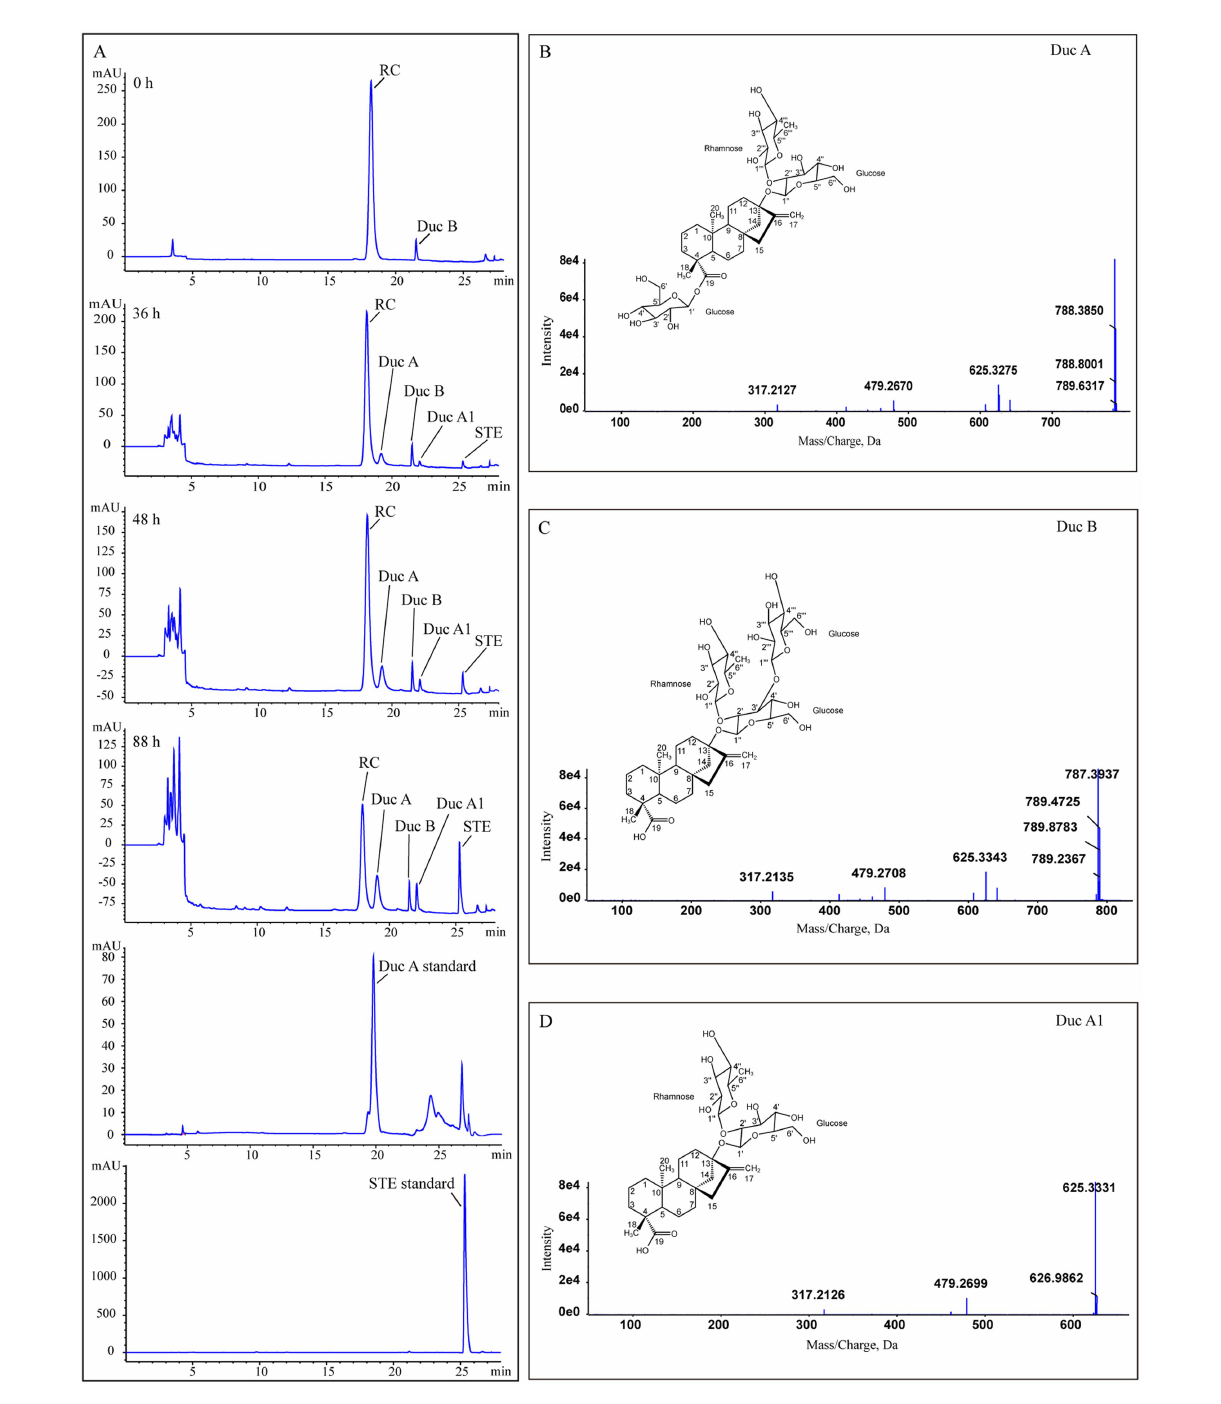
FIGURE 2 Identification of RC metabolites. (A) HPLC chromatograms of Duc A, SET standards, and samples from the treatment group at different times, (B–D) the MS/MS spectra and structures of Duc A, Duc B, and Duc A1,